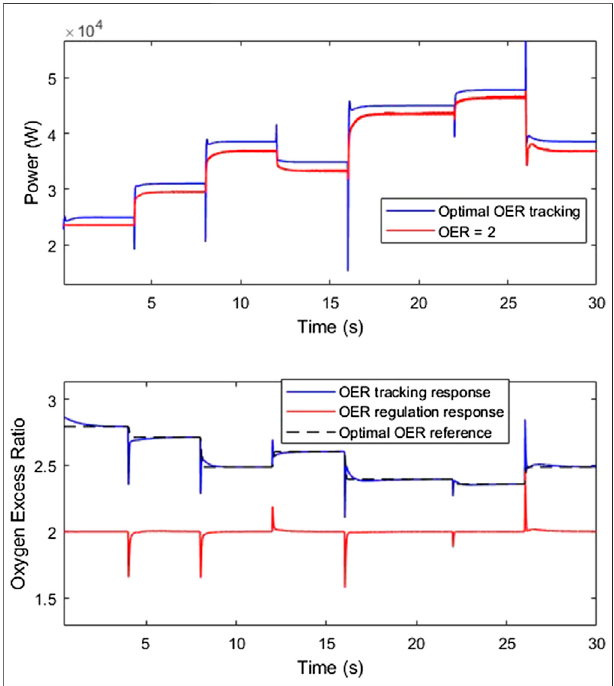
FIGURE 11 | Net power with optimal OER adaptation at T st (cid:1) 50 °